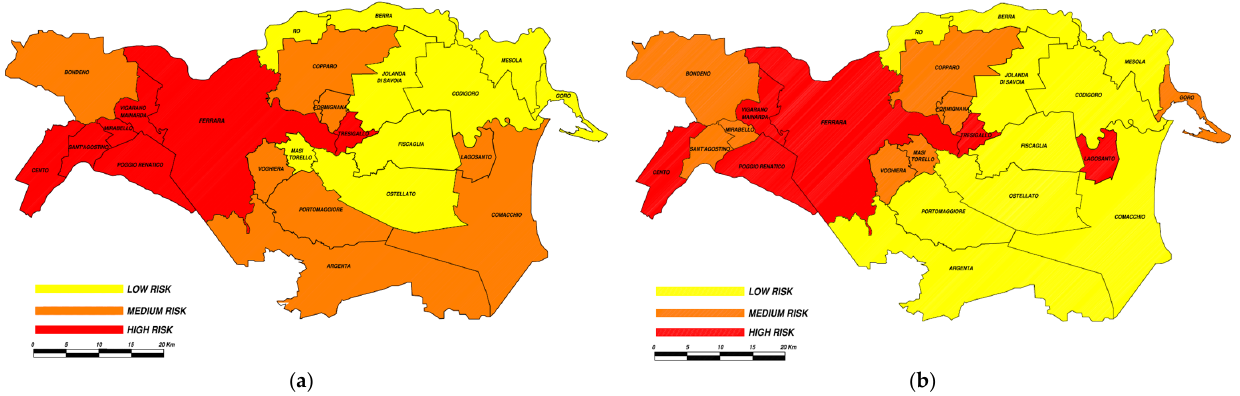
Figure 14. Weights sensitivity analysis, multi-risk maps; ( a ) Scenario 2, population density weight increase; ( b ) Scenario 3, population density weight increase. The risk levels strictly indicate the relative priority ranking for decision-makers and do not indicate the effective safety level of the various municipalities.